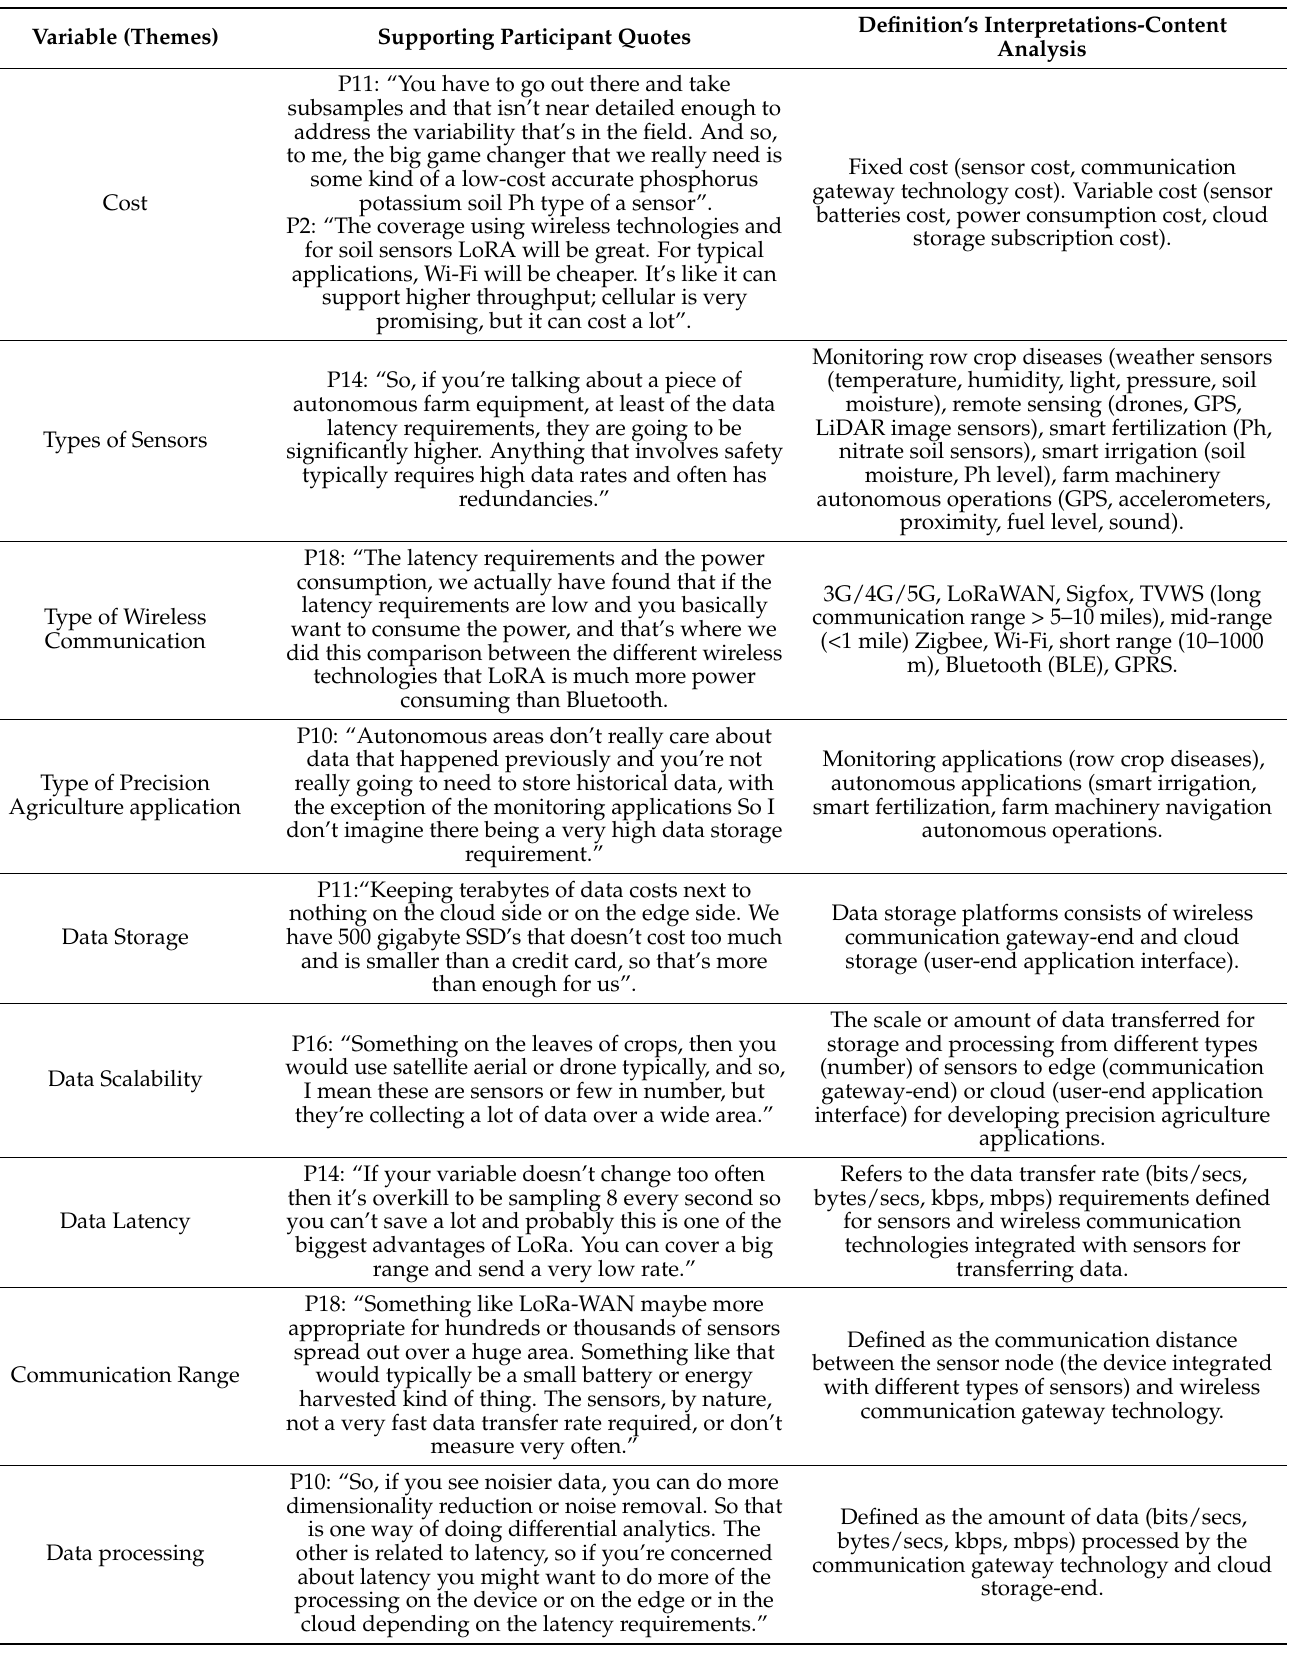
Table 2. Operational